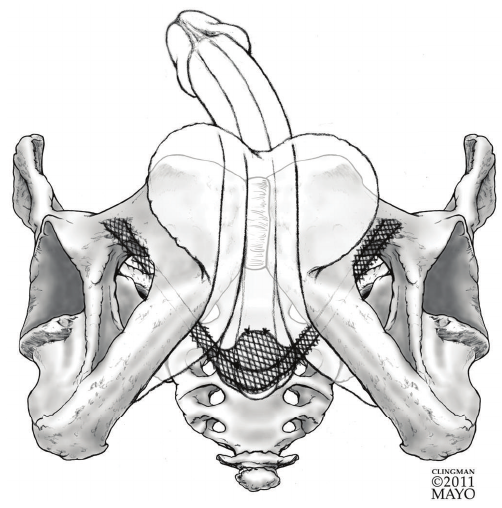
Figure 2: Graphical representation of the retrourethral transobtu- rator sling.